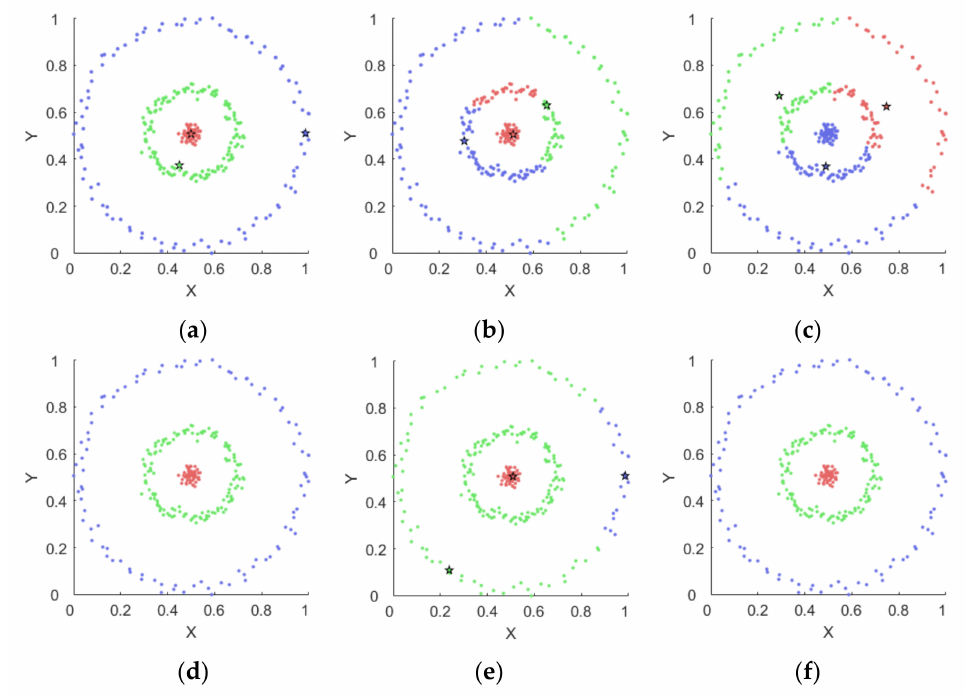
Figure 10. Results on ThreeCircle. ( a ) ConDPC, ( b ) DPC, ( c ) K-means, ( d ) DBSCAN, ( e ) DPC-DBFN, ( f )